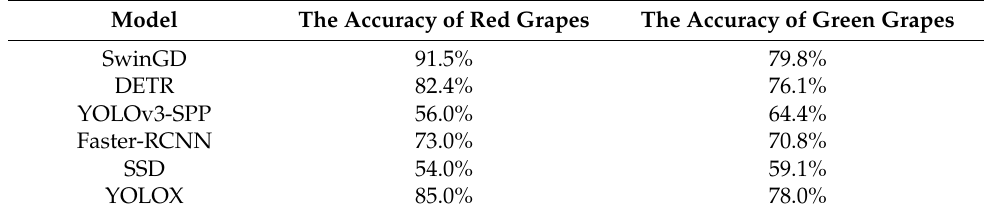
Table 2. The accuracy of green grapes and red grapes in different